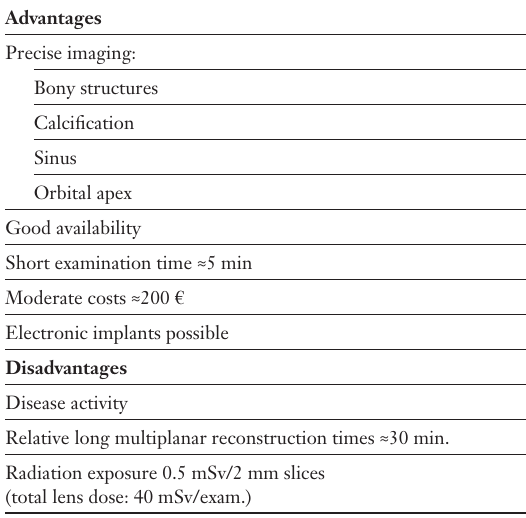
Advantages and disadvantages of CT-imaging in Graves’ orbitopathy.